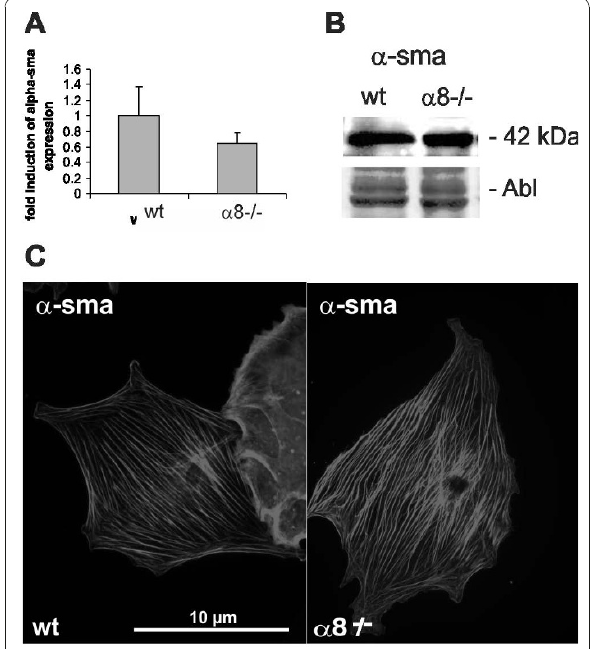
Figure 6 Comparison of a -smooth muscle actin expression in wild type (wt) and a 8 integrin-deficient ( a 8-/-) freshly isolated vascular smooth muscle cells . a 8 integrin expression by real-time RT-PCR analysis (A), Western blot analysis with amido black (Abl) staining as loading control. (B) and immunofluorescent detection (C) (x1000). Results are representative for at least 3 similar experiments.